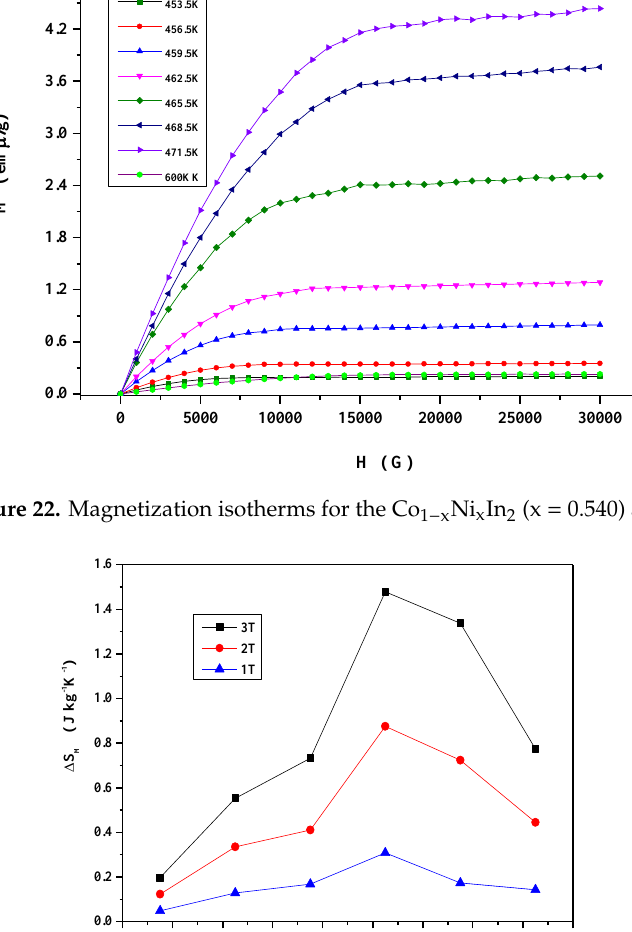
Figure 23. The magnetic entropy changes as a function of temperature under 3 T, 2 T, and 1 T magnetic fields for the Co 1 − x Ni x In 2 (x = 0.540) alloy.